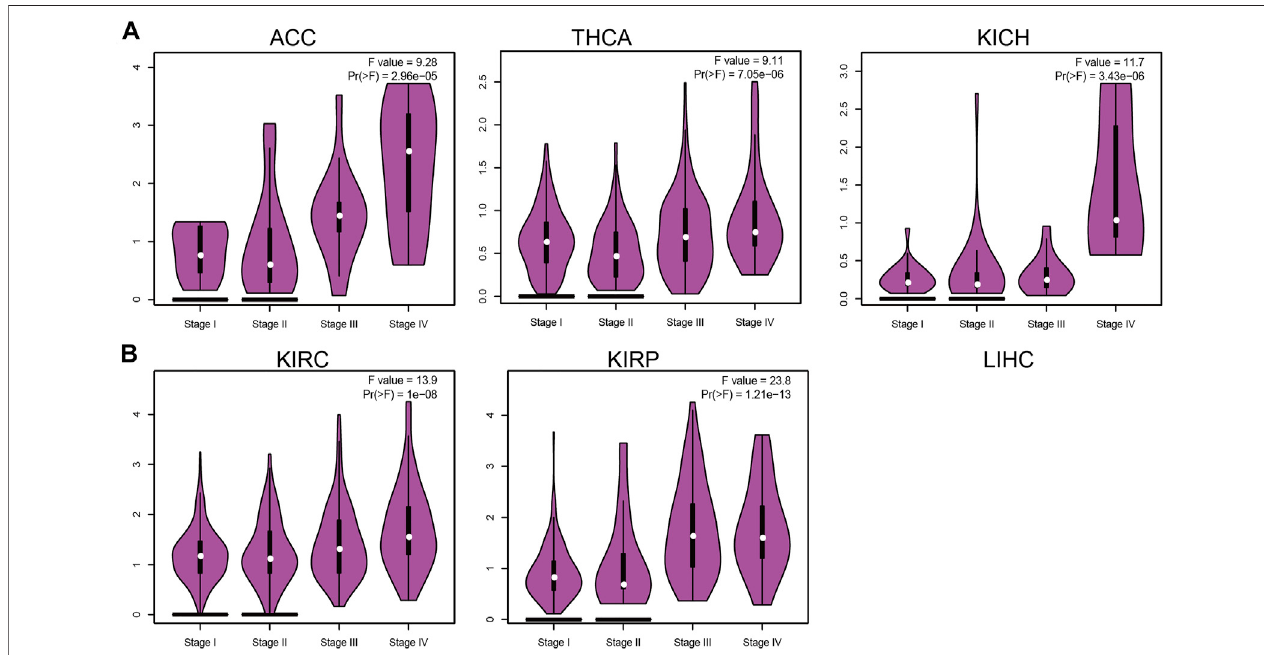
FIGURE 2 | Analysis of the tumor stage for IQGAP3 in human cancers. (A) Analysis of the tumor stage for IQGAP3 in adrenocortical carcinoma, thyroid carcinoma, and kidney chromophobe, and (B) analysis of the tumor stage for IQGAP3 kidney renal clear cell carcinoma, and kidney renal papillary cell carcinoma by using the GEPIA database.